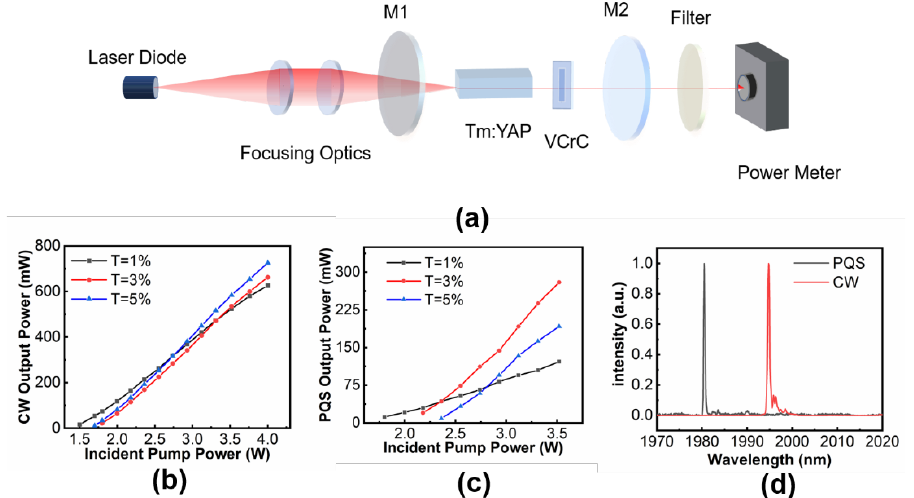
Figure 3. ( a ) Schematic diagram of the MXene VCrC Q-switched Tm:YAP laser experiment. ( b ) Output powers versus incident pump powers for Tm:YAP lasers in CW regime and ( c ) PQS regime. ( d ) The output spectra for the Tm:YAP lasers.